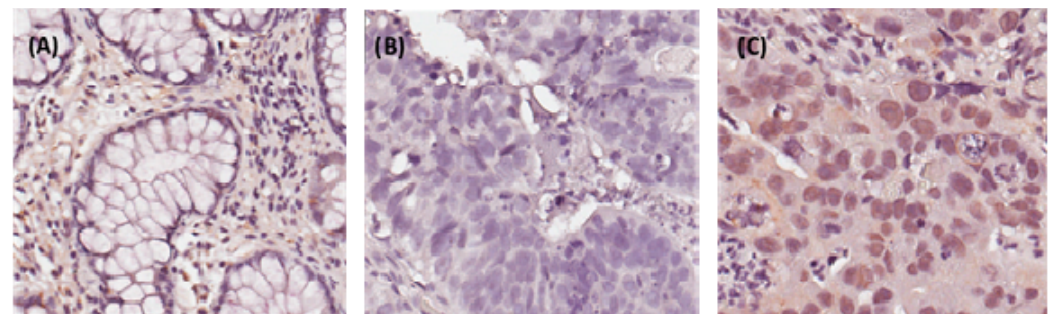
Figure 2. Immunohistochemical staining of CHD4 in representative human rectal tumor sections. ( A ) No expression in normal colonic mucosa. ( B ) Low CHD4 immuno-reactivity in tumors with high tumor regression grades following pre-operative chemo-radiation therapy. ( C ) High CHD4 immuno-reactivity in tumors with low tumor regression grades. Table 1. Associations and comparisons between CHD4 expression and clinicopathological factors in 172 rectal cancer patients who were receiving neoadjuvant CCRT. High expression of CHD4 was significantly associated with pre-Tx tumor status ( p < 0.001), pre-Tx lymph node metastasis ( p < 0.001), post-Tx tumor status ( p < 0.001), post-Tx lymph node metastasis ( p < 0.001), vascular invasion ( p = 0.042), and tumor regression grade ( p = 0.001).